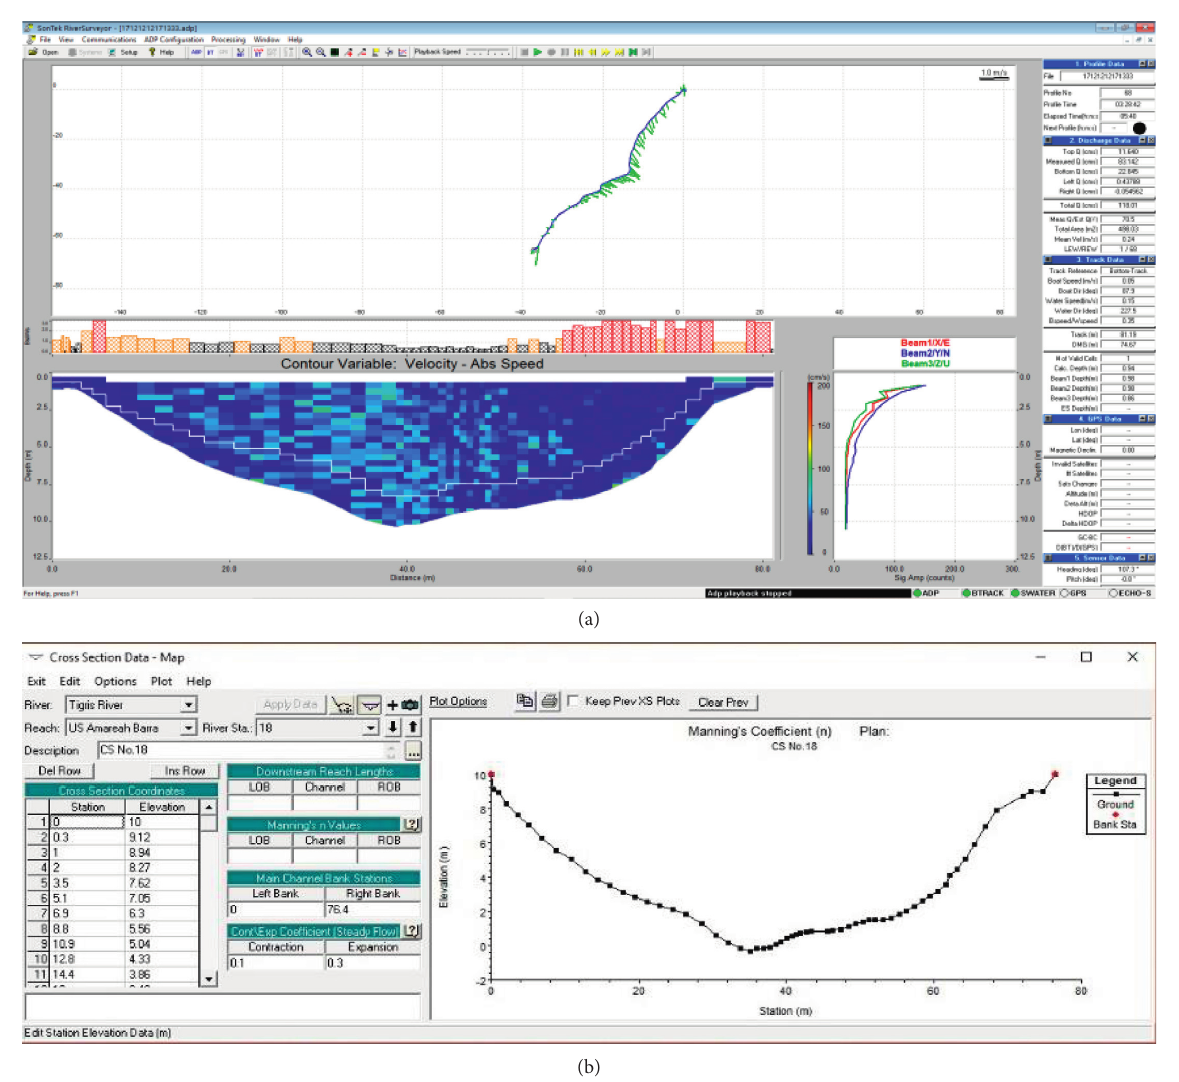
Figure 4: A sample of cross sections. (a) Cross section No. 18 from the ADCP. (b) Same cross section in the